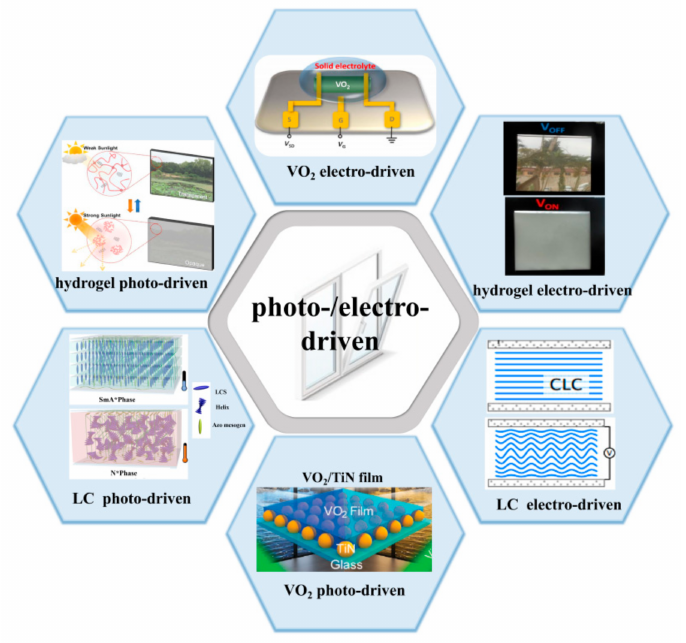
Figure 1. Types and working principle of photo- and electro-driven thermochromic smart